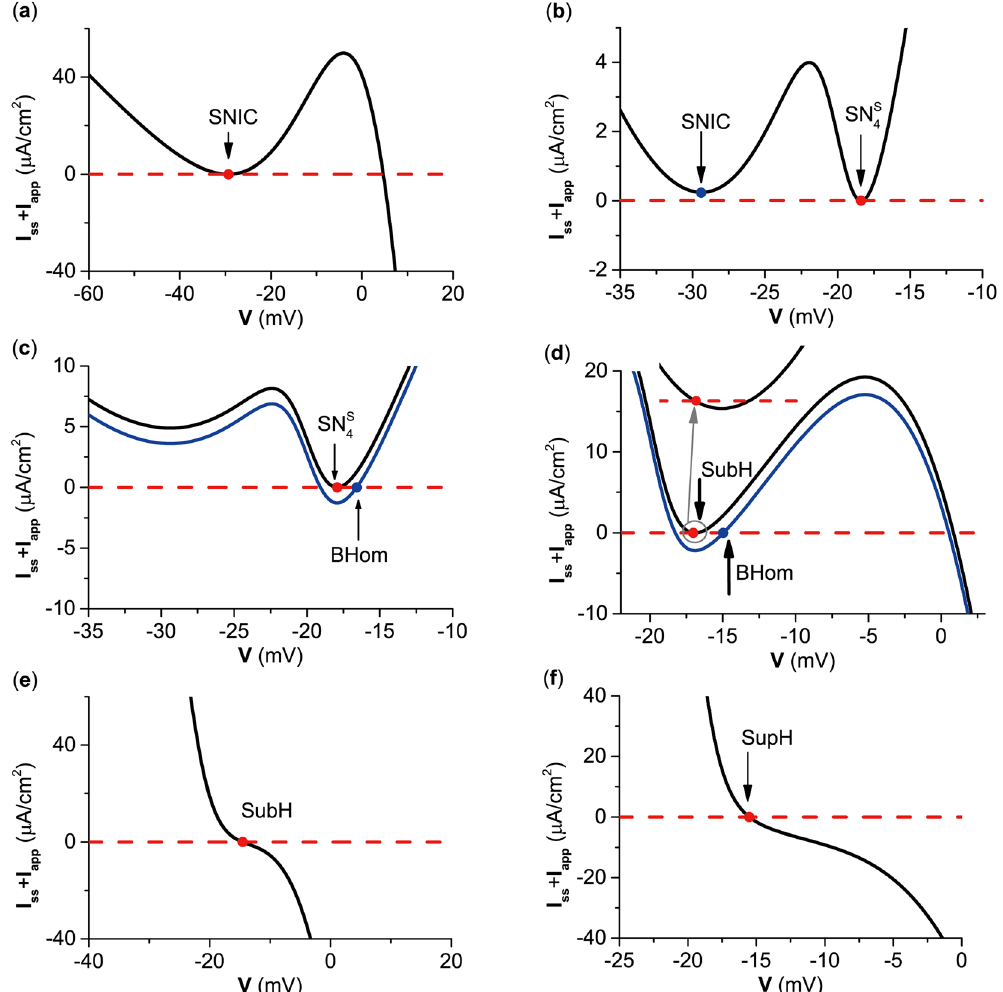
Figure 4. Steady state I–V curves for 5 bifurcation points related to equilibrium. ( a ) g inh = 0 μ S/cm 2 ; ( b ) g inh = 0.372 μ S/cm 2 ; ( c ) g inh = 0.5 μ S/cm 2 ; ( d ) g inh = 1.0 μ S/cm 2 ; ( e ) g inh = 3.5 μ S/cm 2 ; ( f ) g inh = 4.4 μ S/cm 2 . SNIC represents saddle-node bifurcation on an invariant circle. SubH and SupH represent subcritical Hopf bifurcation and supercritical Hopf bifurcation, respectively. BHom represents saddle homoclinic orbit bifurcation. SN 4S represents saddle node bifurcation of